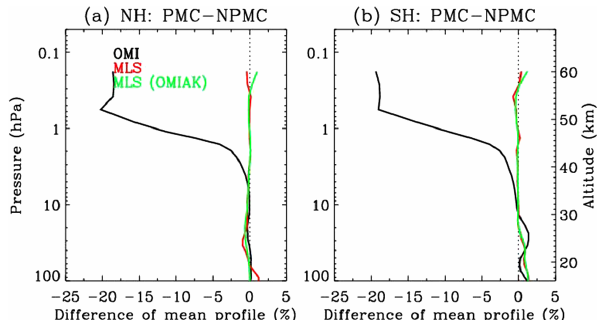
Figure 2. Difference in mean ozone profiles of OMI (black), MLS(red), and MLS convolved with OMI averaging kernels (green) between PMC and non-PMC pixels as functions of MLS vertical layers, for (a) NH 2007 (July 2007, 75–85 ◦ N) and (b) SH 2008 (January 2008, 75–85 ◦ S) summer